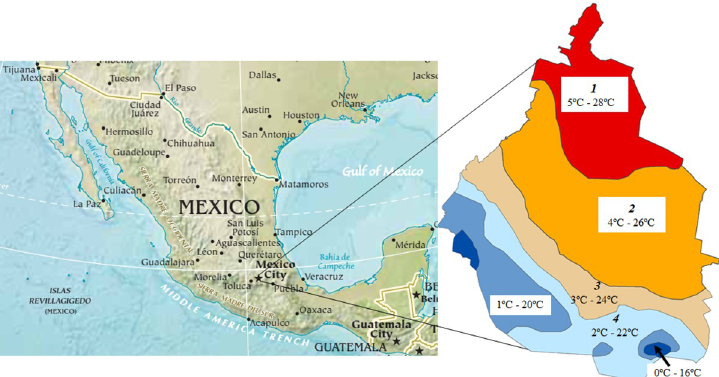
Fig 1. Mexico city location. Lowest and highest average annual temperatures in the city are shown. Map modified from https://www.cia.gov/library/publications/the-world-factbook/attachments/docs/original/north_america.pdf?